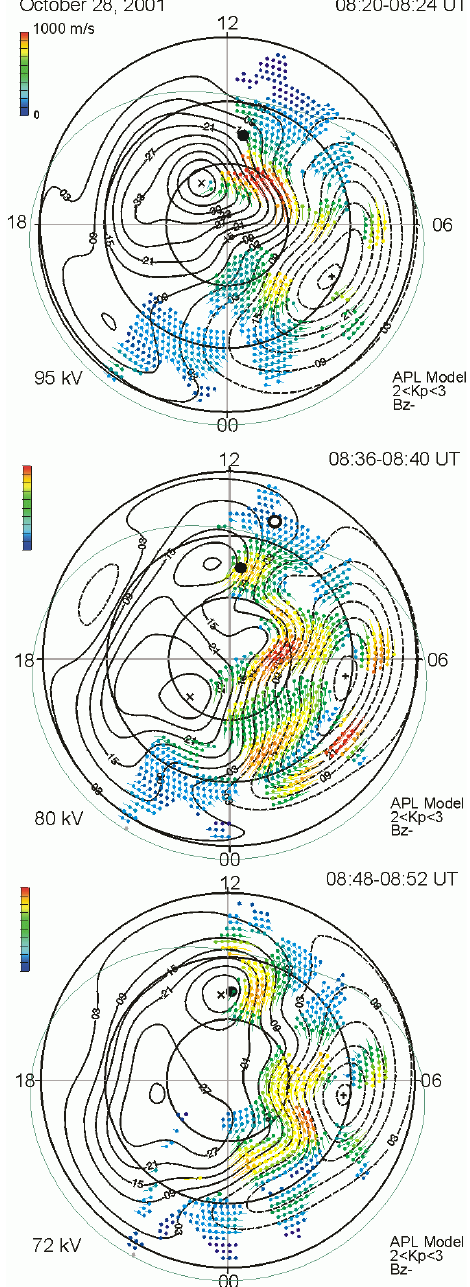
Fig. 7. The SuperDARN convection vectors showing the two-cell pattern of ionospheric convection before (top), during (middle) and after (bottom) the Pc1 event. The BAB location is indicated with filled circle. An open circle indicates the cusp